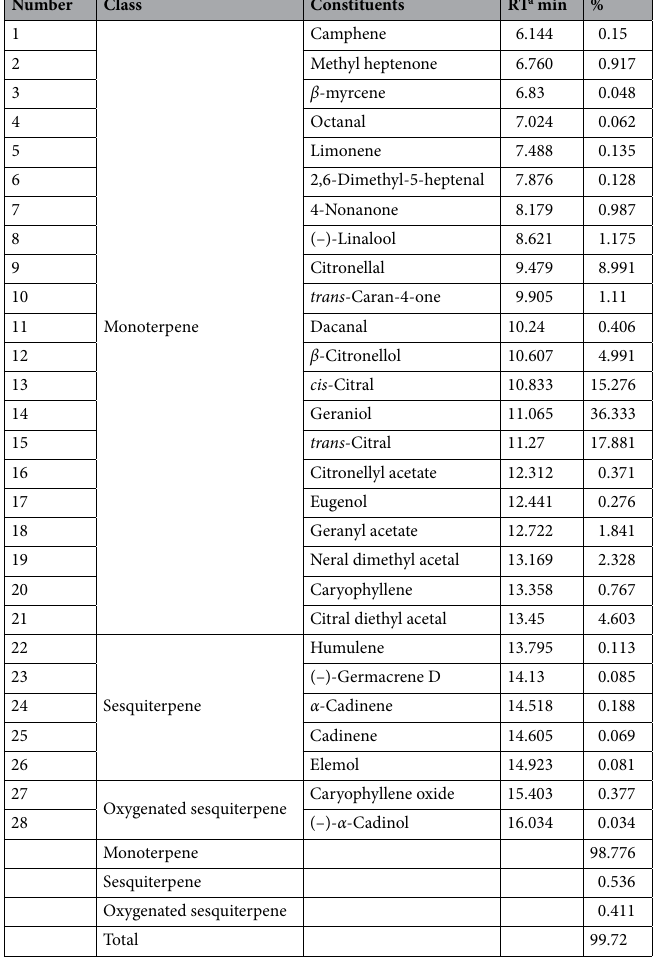
Table 2. Chemical composition of EO from citronella